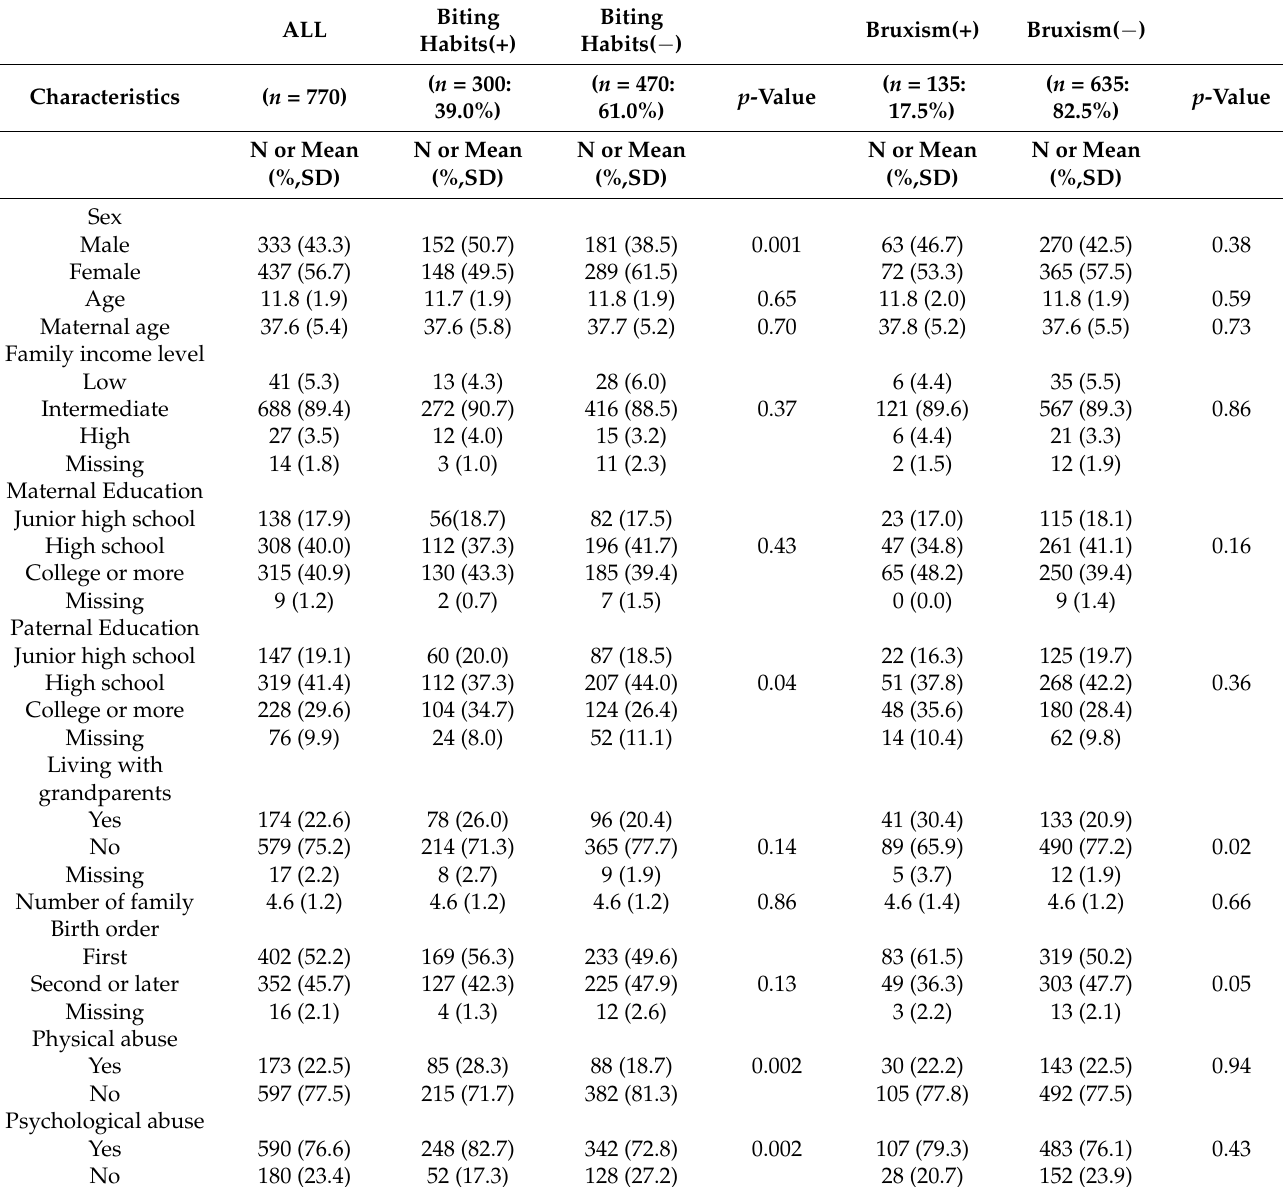
Table 1. Demographic characteristics of the participants according to biting